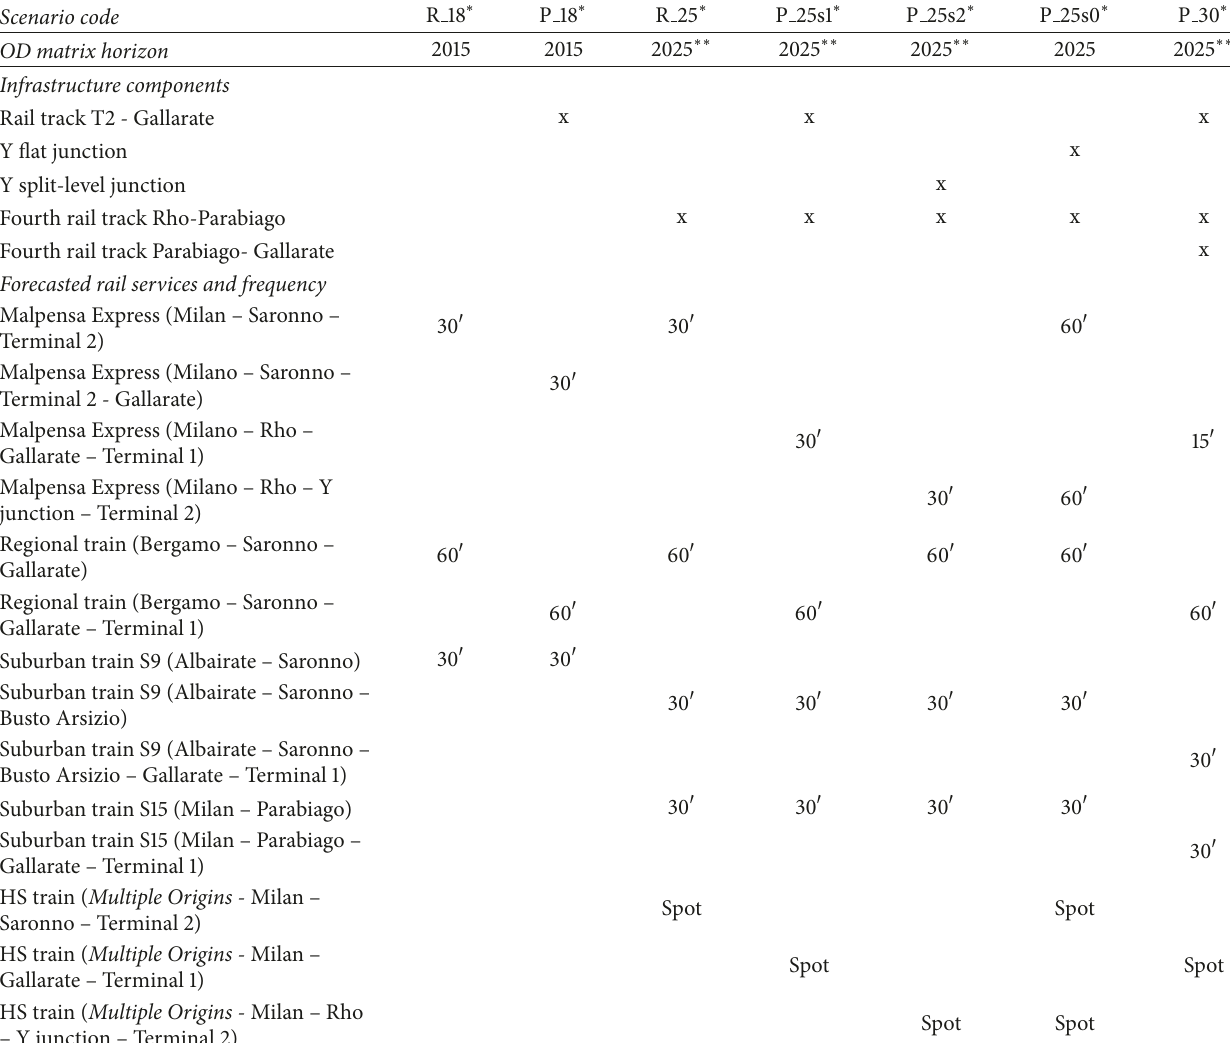
Table 3: Project